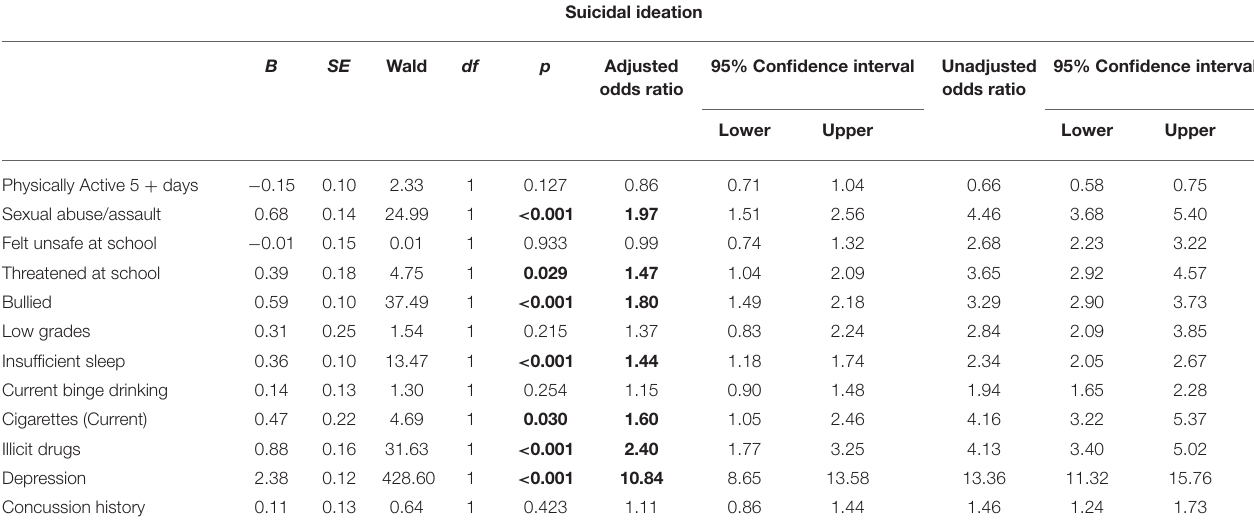
TABLE 3 | Logistic regressions predicting suicidality in